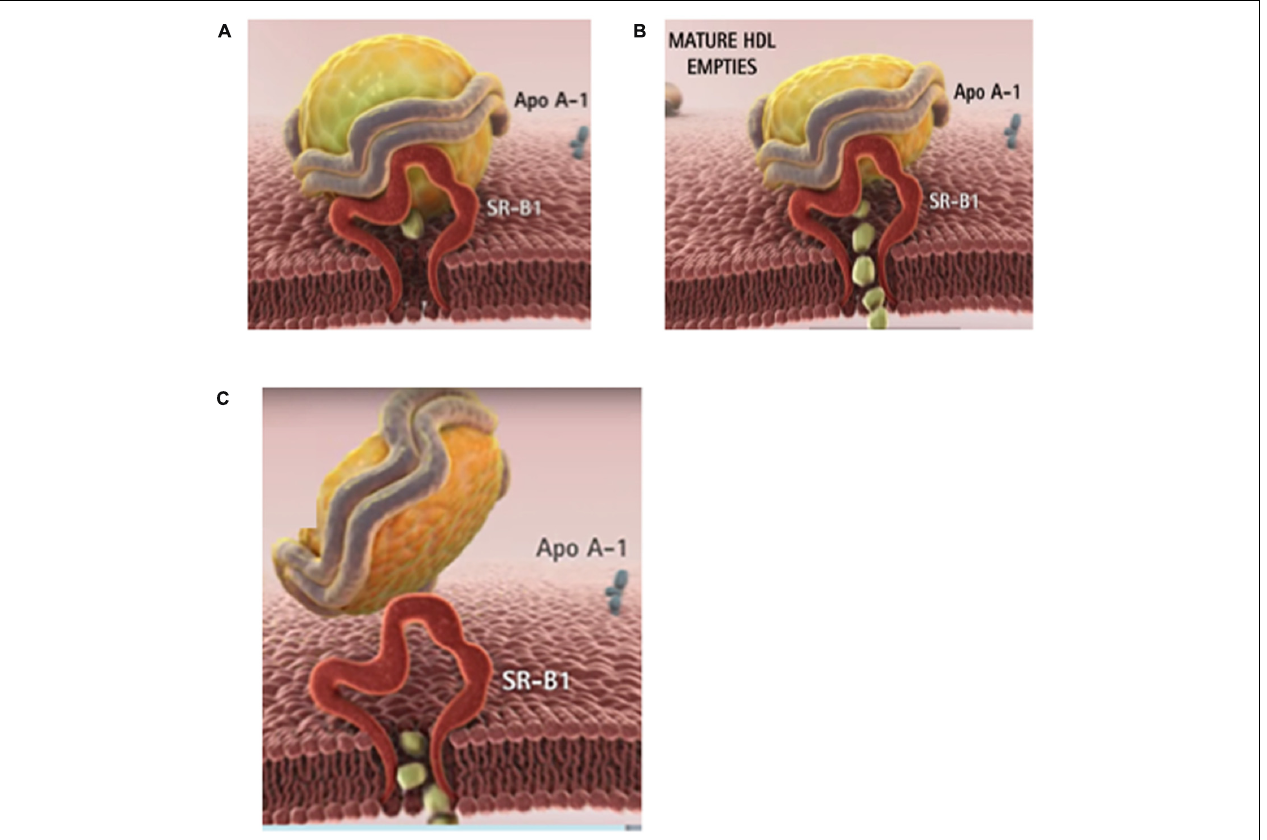
FIGURE 1 | The physiological role of HDL is to clear the excess tissue cholesterol through the liver. (A) In phase 1, the cholesterol-rich HDL is captured by the SR-B1 receptor on the surface of the cell. (B) In phase 2, HDL delivers its cholesteryl ester cargo through SR-B1 directly into the cytoplasm. (C) In phase 3, the depleted HDL particle is released into the blood. The majority of cancer patients have lower than normal blood cholesterol especially HDL (or good) cholesterol. Images courtesy of Andras Lacko; full animation video is available at https://www.youtube.com/watch?v =